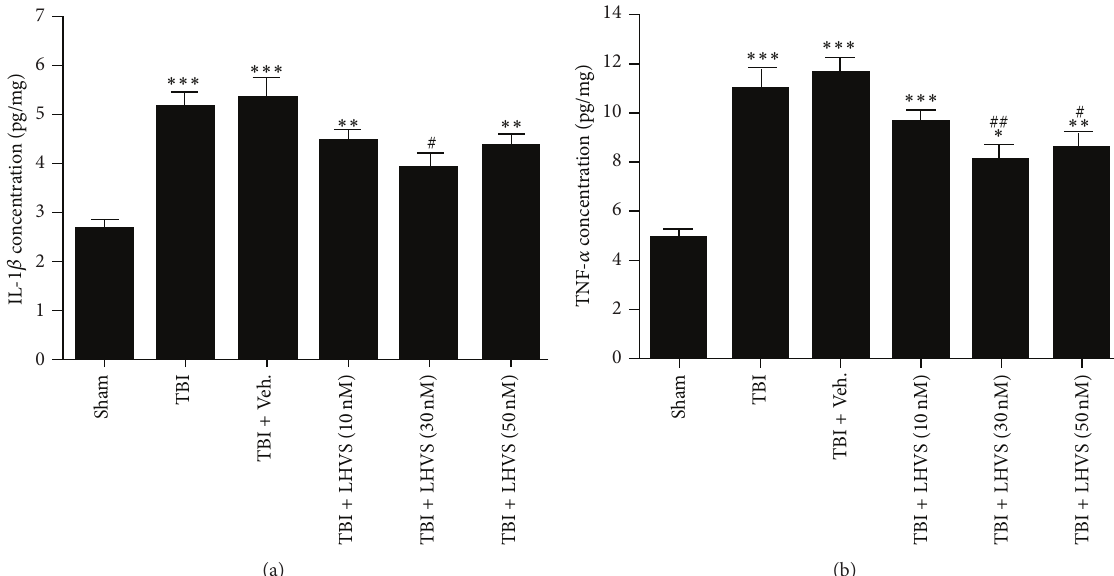
Figure 5: LHVS suppresses the upregulation of proinflammatory cytokines (IL-1 𝛽 and TNF- 𝛼 ) in the ipsilateral cortex at 24 h after traumatic brain injury (TBI). (a) IL-1 𝛽 concentration was increased significantly in the TBI and TBI + vehicle groups compared with that in the sham group. Pretreatment with LHVS significantly attenuated IL-1 𝛽 levels in the ipsilateral cortex compared with vehicle pretreatment. (b) TNF- 𝛼 concentration was increased significantly in the TBI and TBI + vehicle groups compared with that in the sham group. Pretreatment with LHVS significantly attenuated TNF- 𝛼 levels in the ipsilateral cortex compared with vehicle pretreatment. Data are presented as mean ± SEM ( 𝑛 = 6 ). ∗∗∗ 𝑃 < 0.001 , ∗∗ 𝑃 < 0.01 versus sham group; # 𝑃 < 0.05 , ## 𝑃 < 0.01 versus TBI + vehicle group.